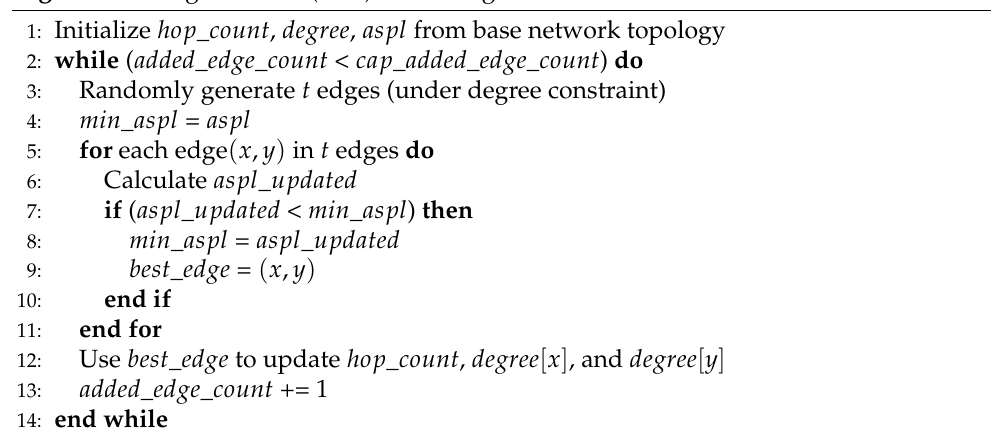
Algorithm 1 EdgeCut-Full (ECF) for adding